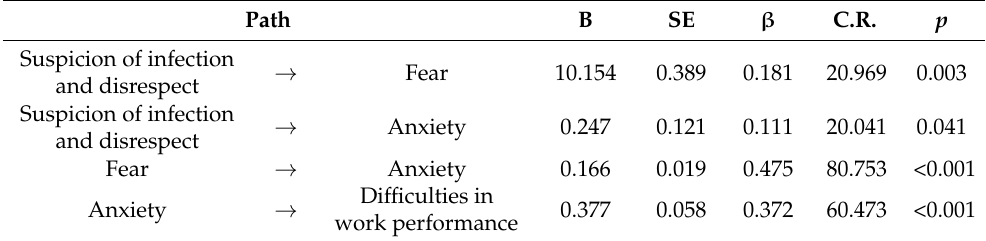
Table 2. Result of path